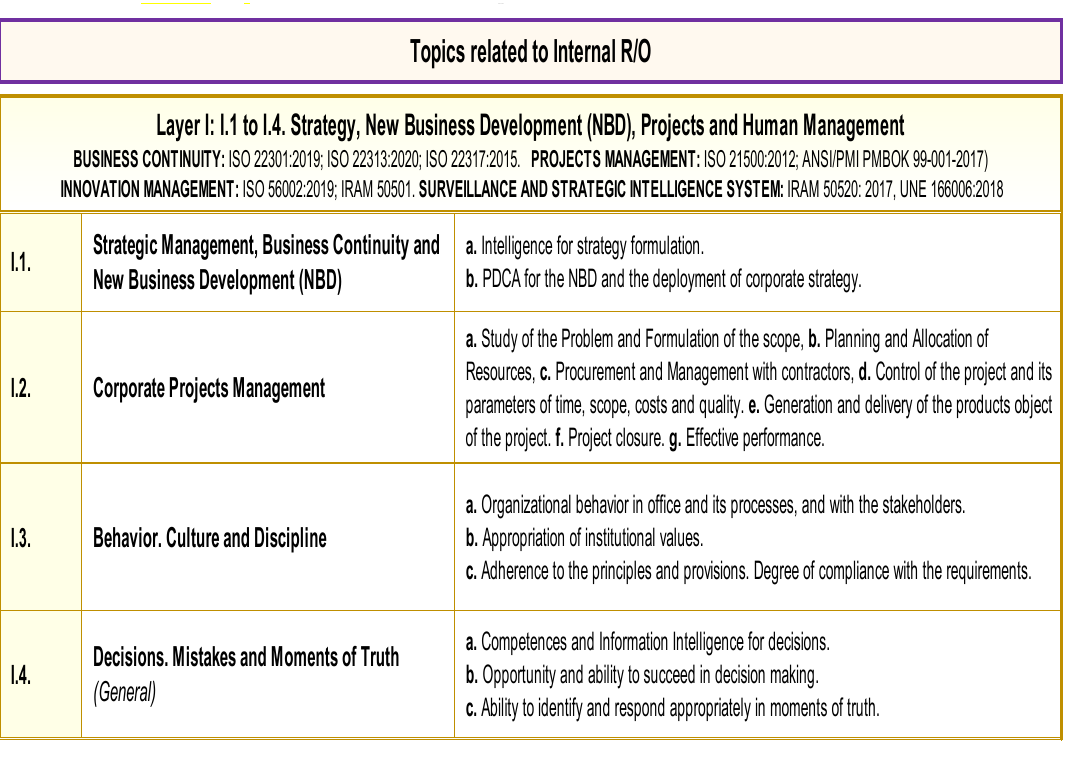
Figure A9. Classification matrix of topics related to internal R/O. Layer I: I1 to I.4. [14,51,65,101].